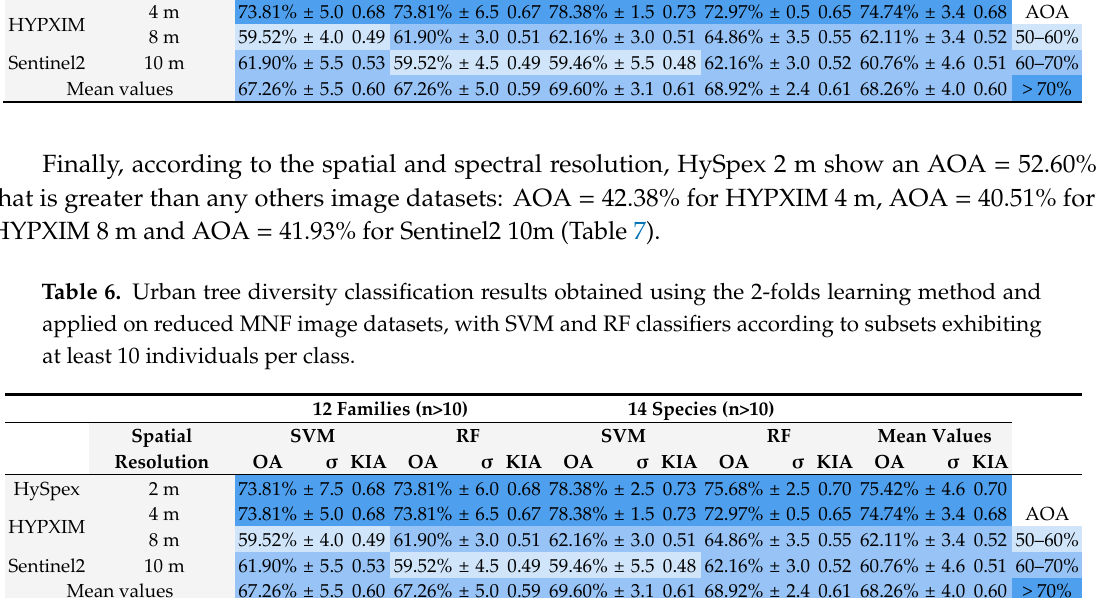
Table 7. Classifications mean results by spatial resolution and dimension reductions using the 2-folds learning method.